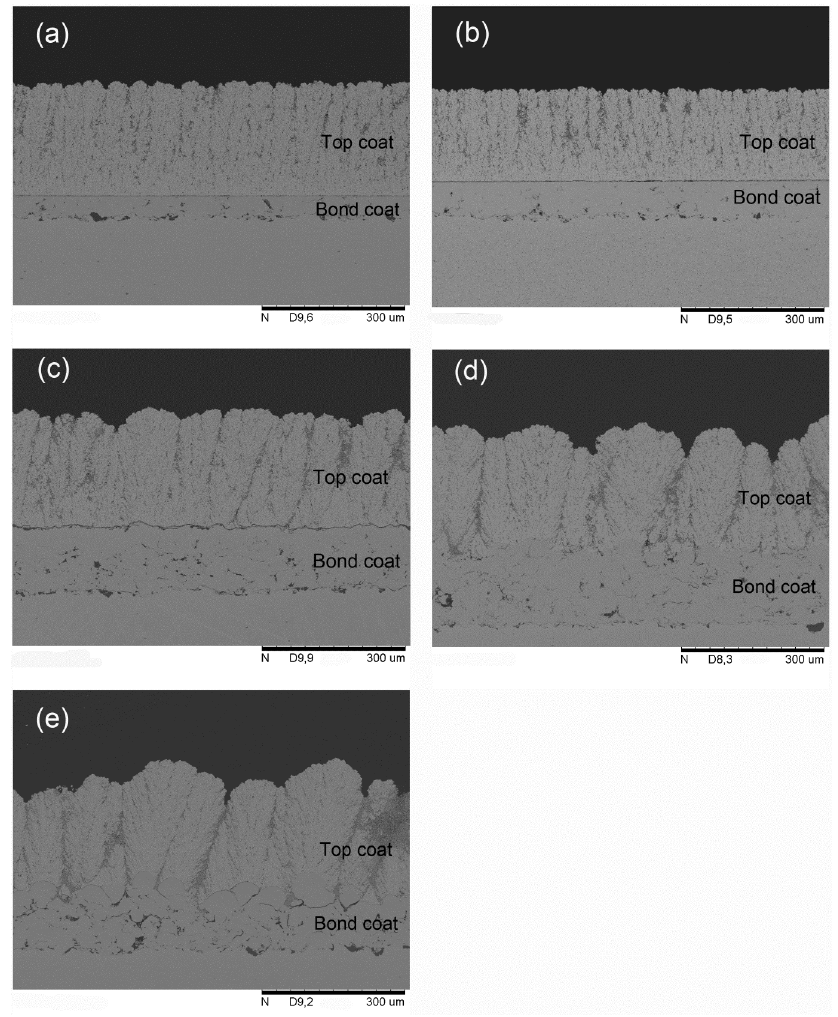
Figure 3. Cross ‐ section SEM images of as ‐ sprayed YSZ top coats (Samples E–I) deposited at a standoff distance of 100 mm, on BC with different surface treatments: ( a ) mirror polishing; ( b ) grinding; ( c ) grit blasting; ( d ) as ‐ sprayed; and ( e ) as ‐ sprayed rough.